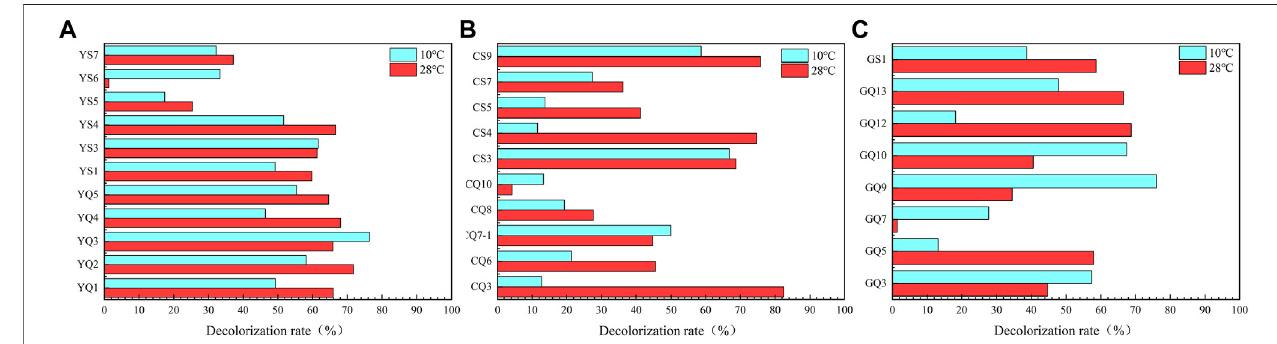
FIGURE 6 | Decolorization rate of DCPIP, which indicating potential of diesel degradation ability. ( A -method Y; B -method C; C -method G).